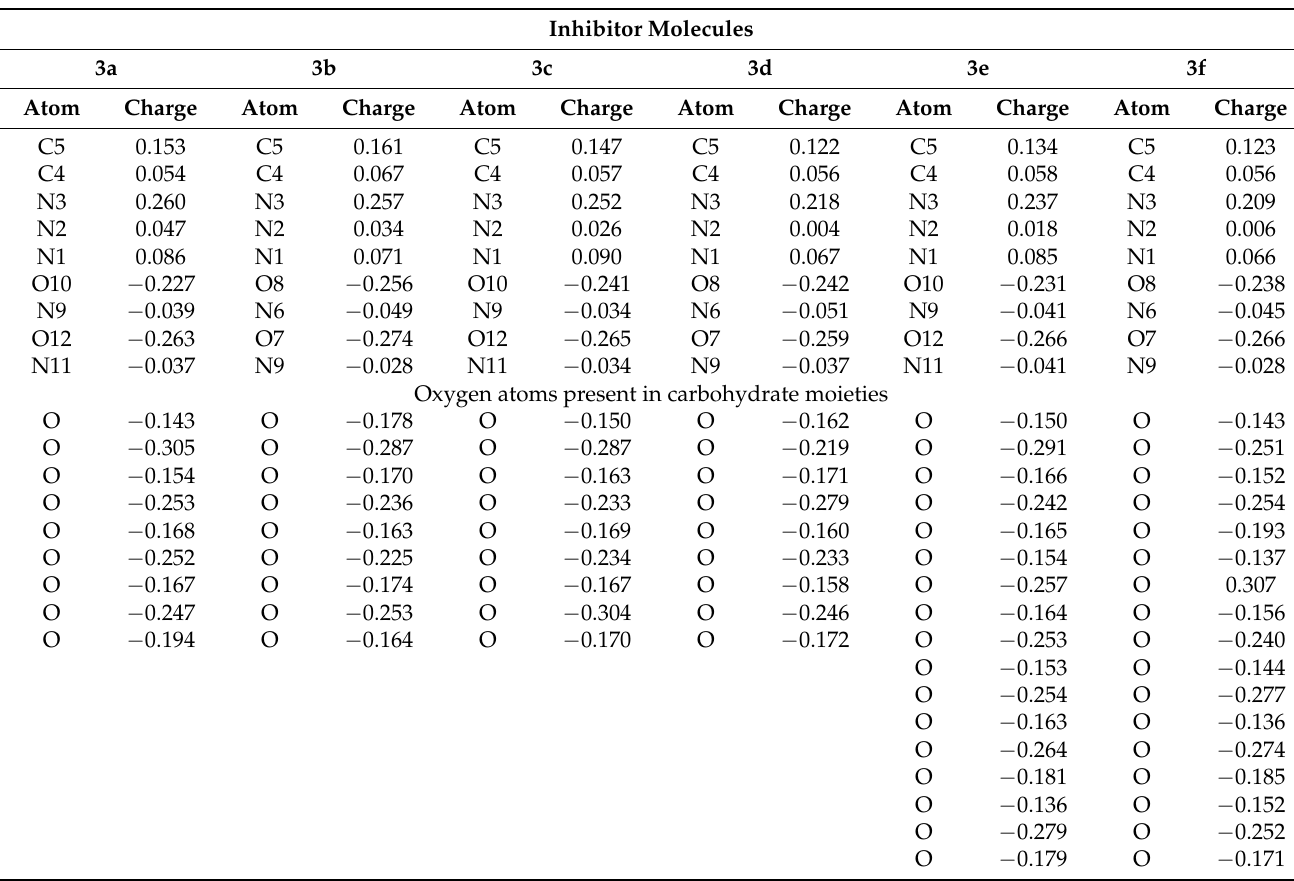
Table 10. Hirshfeld charges of protonated